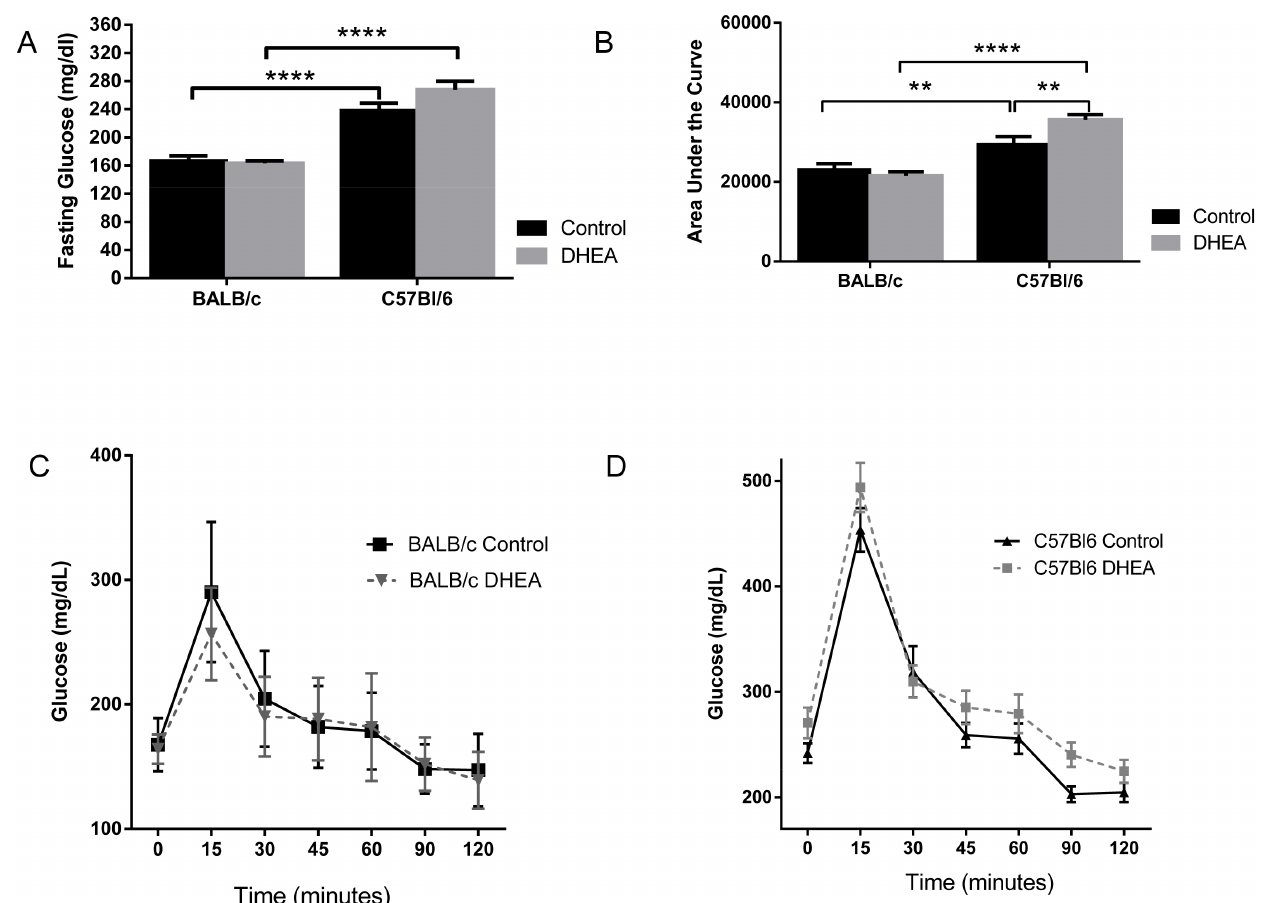
Figure 3. DHEA treatment impairs glucose tolerance in C57Bl6 female mice. A. Glucose tolerance test of BALB/cByJ females, treated and untreated. n=7–9. B. Glucose tolerance test of C57Bl6 females, treated and untreated. n=10. C. Fasting glucose levels of BALB/cByJ and C57Bl6 females. BALB/cByJ n=9 and C57Bl6 n=16 D. Area under the curve of glucose tolerance test of BALB/cByJ and C57Bl/6 females, n=7–10. E. Fasting insulin levels upon dissection after overnight fast. n=6–9.